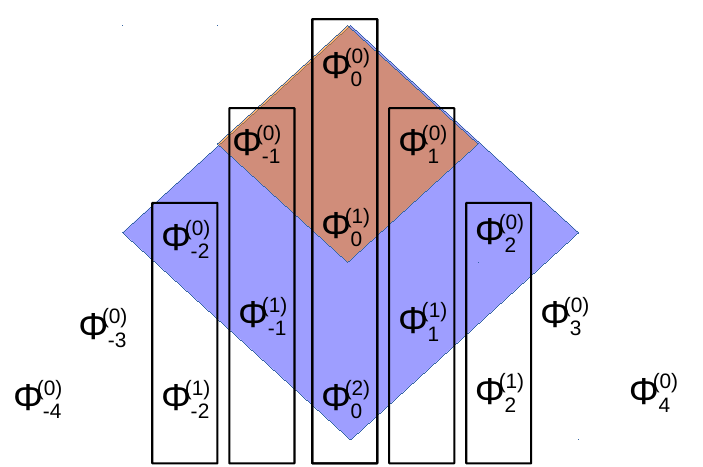
Figure 9. Resurgence theory allows us to move vertically along each rectangle. From just one of the contributions in a topological sector, i.e. (cid:8) ( k )